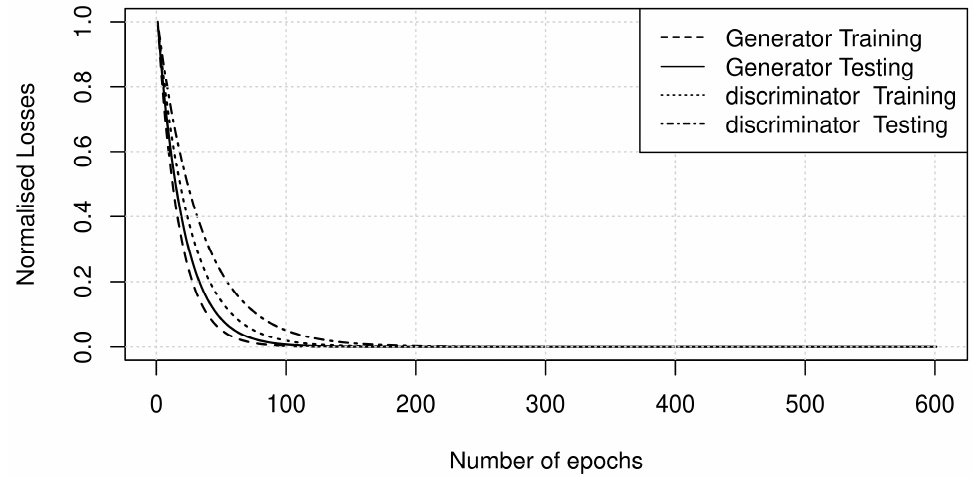
Figure 6. Graph of loss function changes versus number of epochs for the generator and discriminator during training.